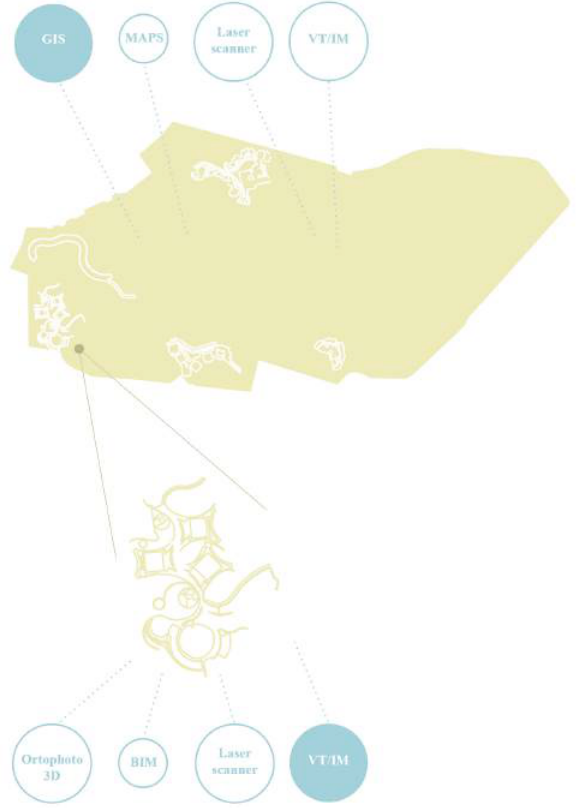
Table 4. Double-scale approach of the CMP for the National